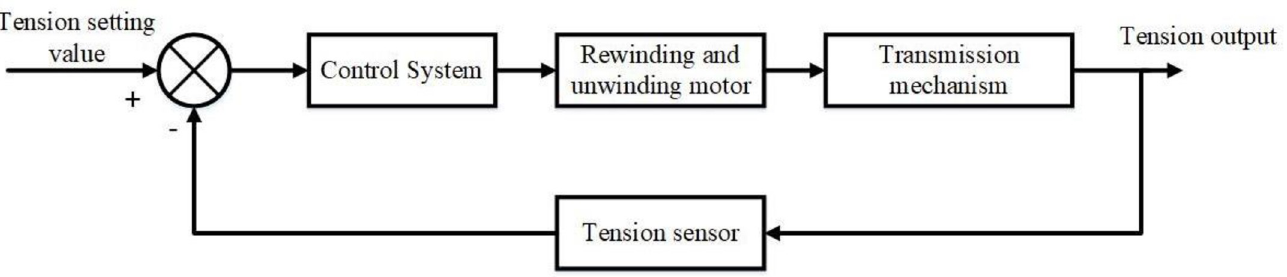
Fig 9. Tension closed-loop control flow